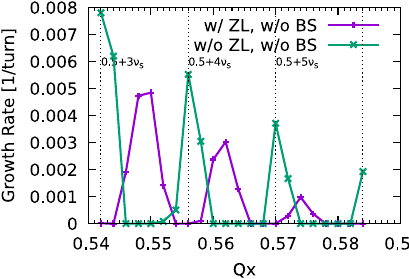
FIG. 6. The horizontal beam size growth rate versus horizontal tunewithandwithoutlongitudinal couplingimpedance(ZL),where beamstrahlung (BS) effect is turned off in both cases. The stable equilibrium bunch length and energy spread is same between the two cases, where σ z; and σ p; are tuned in latter case. SR SR